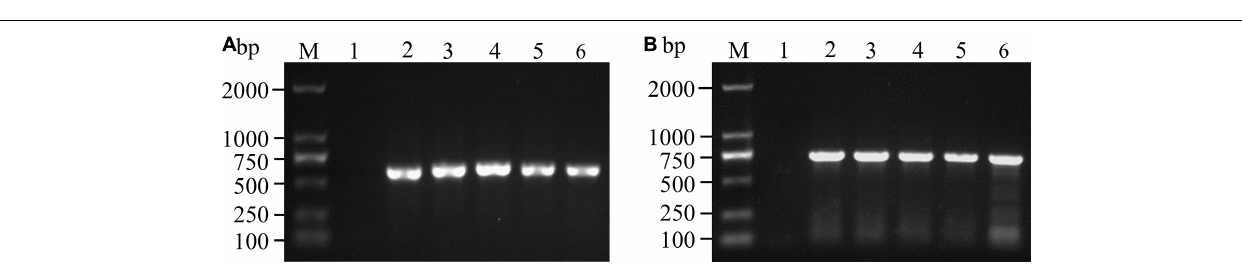
FIGURE 3 | PCR amplification and agarose gel detection of ITS (A) and TEF-1 α (B) genes. M: DNA molecular weight standard; Lane 1: negative control; Lanes A2-6: PCR products of the ITS gene of some isolates; Lanes B2-6: PCR products of the TEF-1 α gene of some